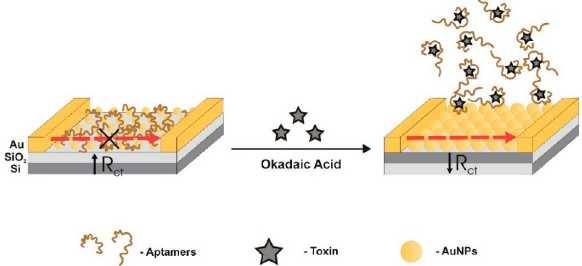
Figure 12. Electrochemical gap-based competitive assay, developed by Pan et al. [51], to detect okadaic acid, using gold nanoparticles (AuNPs). The self-catalytic growth of AuNPs creates conductive bridges. The presence of okadaic acid prevents the interaction of the aptamers and AuNPs, letting AuNPs sites exposed to the occurrence of catalytic growth, therefore inducing a large drop in charge transfer resistance (R ct